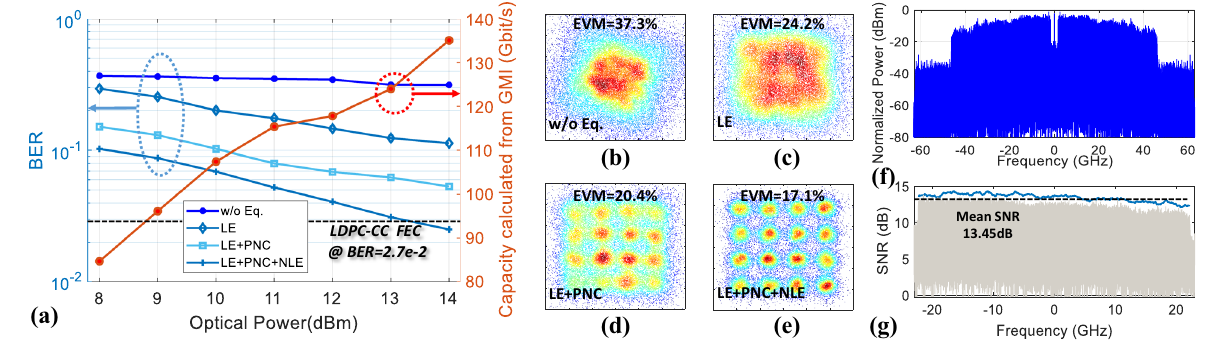
Fig. 5 Transmission results. a BER versus the optical power launched into the UTC-PD for 4 cases with different combinations of DSP modules, the BER y- left-axis is labeled in logarithm-scale with light-blue color grids, the y-right-axis is labeled in linear-scale. b – e The signal constellations before and after the three channel equalization stages at 14 dBm optical power (color in logarithm-scale). f The electrical spectrum of the IF signal before digital down conversion to baseband. g The SNR (blue curve) versus the frequency after down-conversion, the gray-color shading is the shape of the electrical spectrum of the 16-QAM-OFDM signal after down